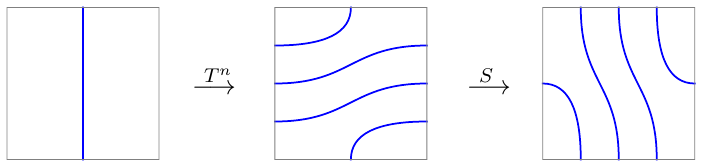
and the cyclic permutation map b C , for an g